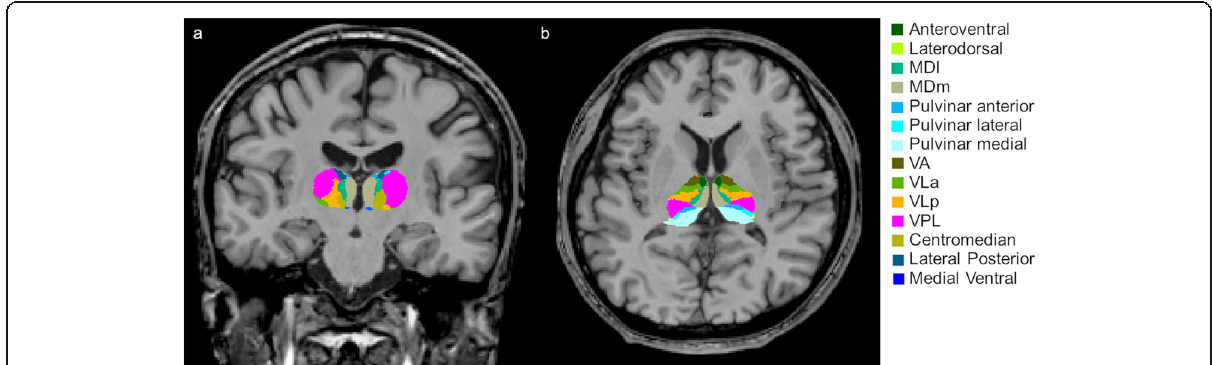
Fig. 1 Example of segmentation of thalamic nucleiSegmentations and labels of thalamic nuclei in the coronal a and axial b plane generated by FreeSurfer (not all segmentations are shown). The segmentations are overlaid on the T1-weighted scan. MDl: mediodorsal lateral parvocellular, MDm: mediodorsal medial magnocellular, VLa: ventral lateral anterior, VLp: ventral lateral posterior, VPL: ventral posterolateral, VA: ventral anterior